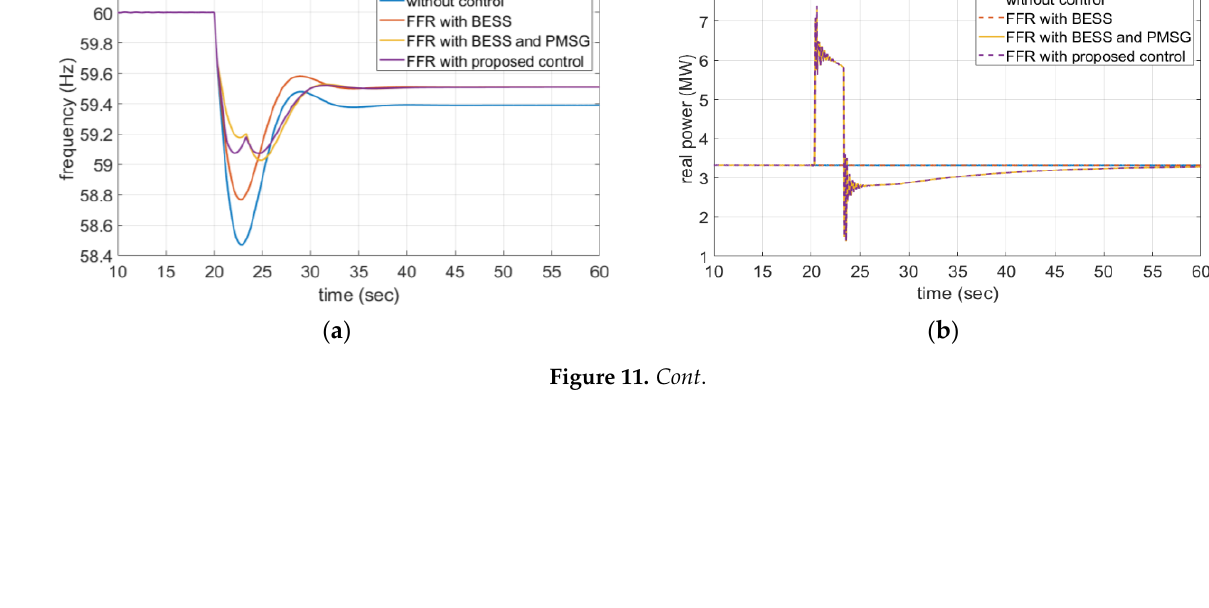
Figure 11. Simulation results: ( a ) system frequency; ( b ) output power of the PMSG type wind turbine; ( c ) output power of synchronous generator #1; ( d ) output power of the BESS.